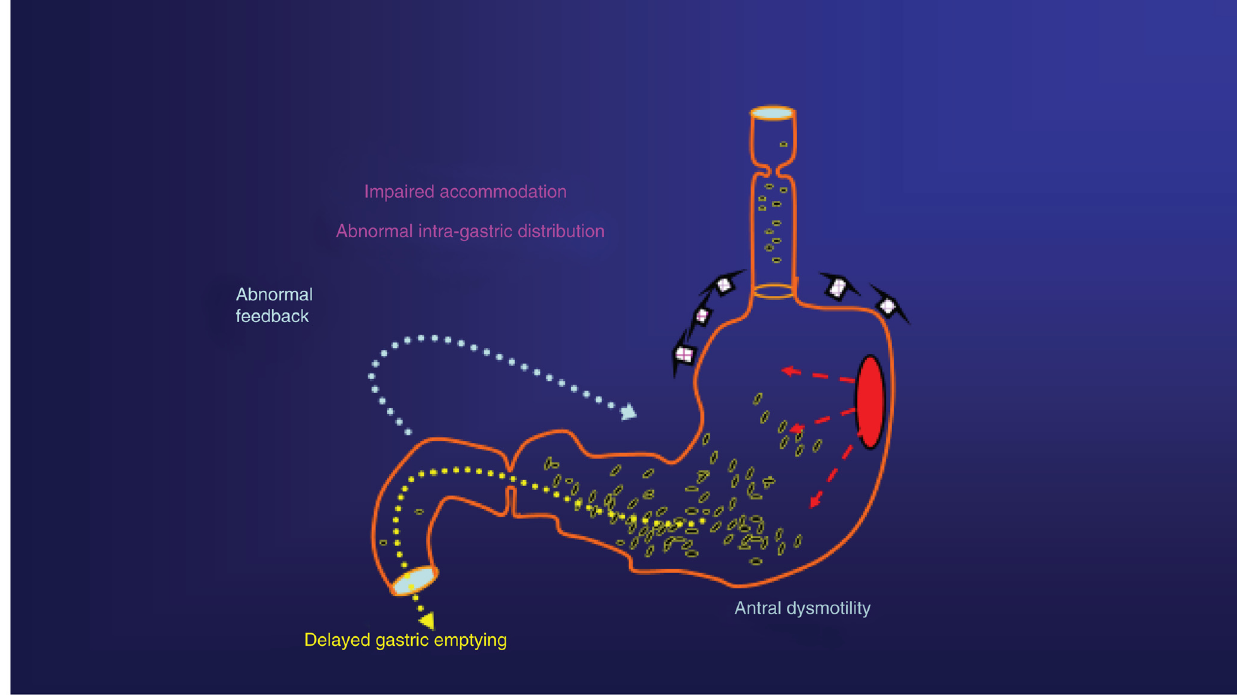
Figure 2. Abnormal gastric motility and function could be implicated in the pathophysiology of symptoms in functional dyspepsia, especially in patients with postprandial distress syndrome. Heightened visceral sensitivity has an important role in epigastric pain syndrome but is also present in many individuals with postprandial distress. In clinical practice, with the exception of detection of abnormal gastric emptying by scintigraphy, it is currently not possible to identify the specific causes of